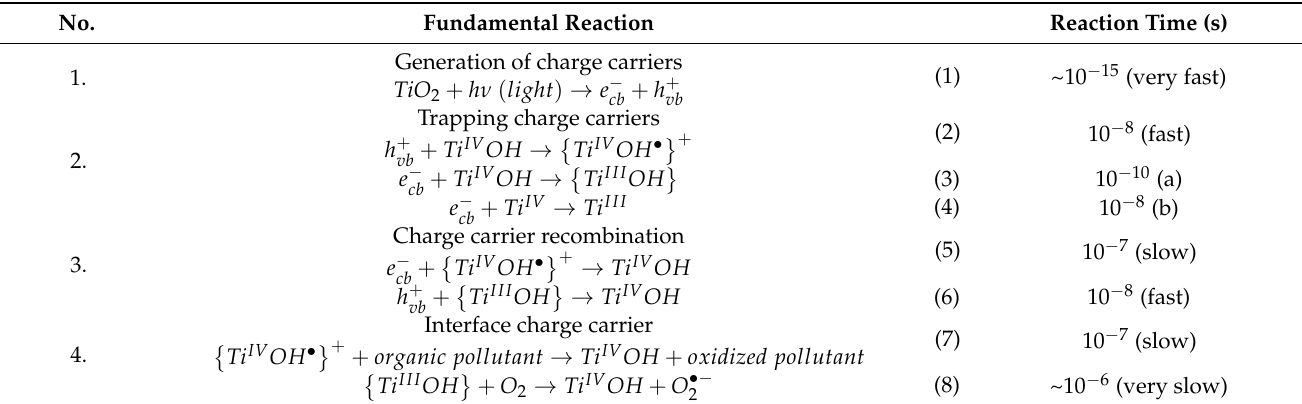
Table 1. Various basic reactions with the respective reaction times for the general process of organic pollutant degradation by TiO 2 photocatalyst [22,23]. Adapted with permission from American Chemical Society and Elsevier, 2022.